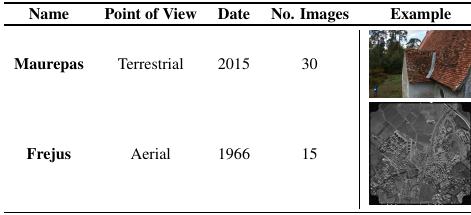
Table 2. Overall description of datasets (credits: IGN/ENSG